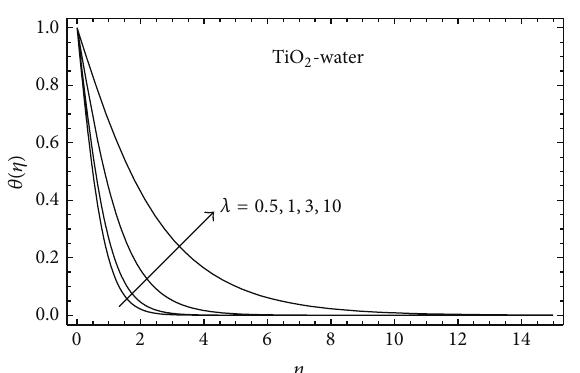
Figure 8: Effect of 𝜆 on temperature distribution 𝜃(𝜂) for Pr = 6.2 and 𝑀 = 1 .